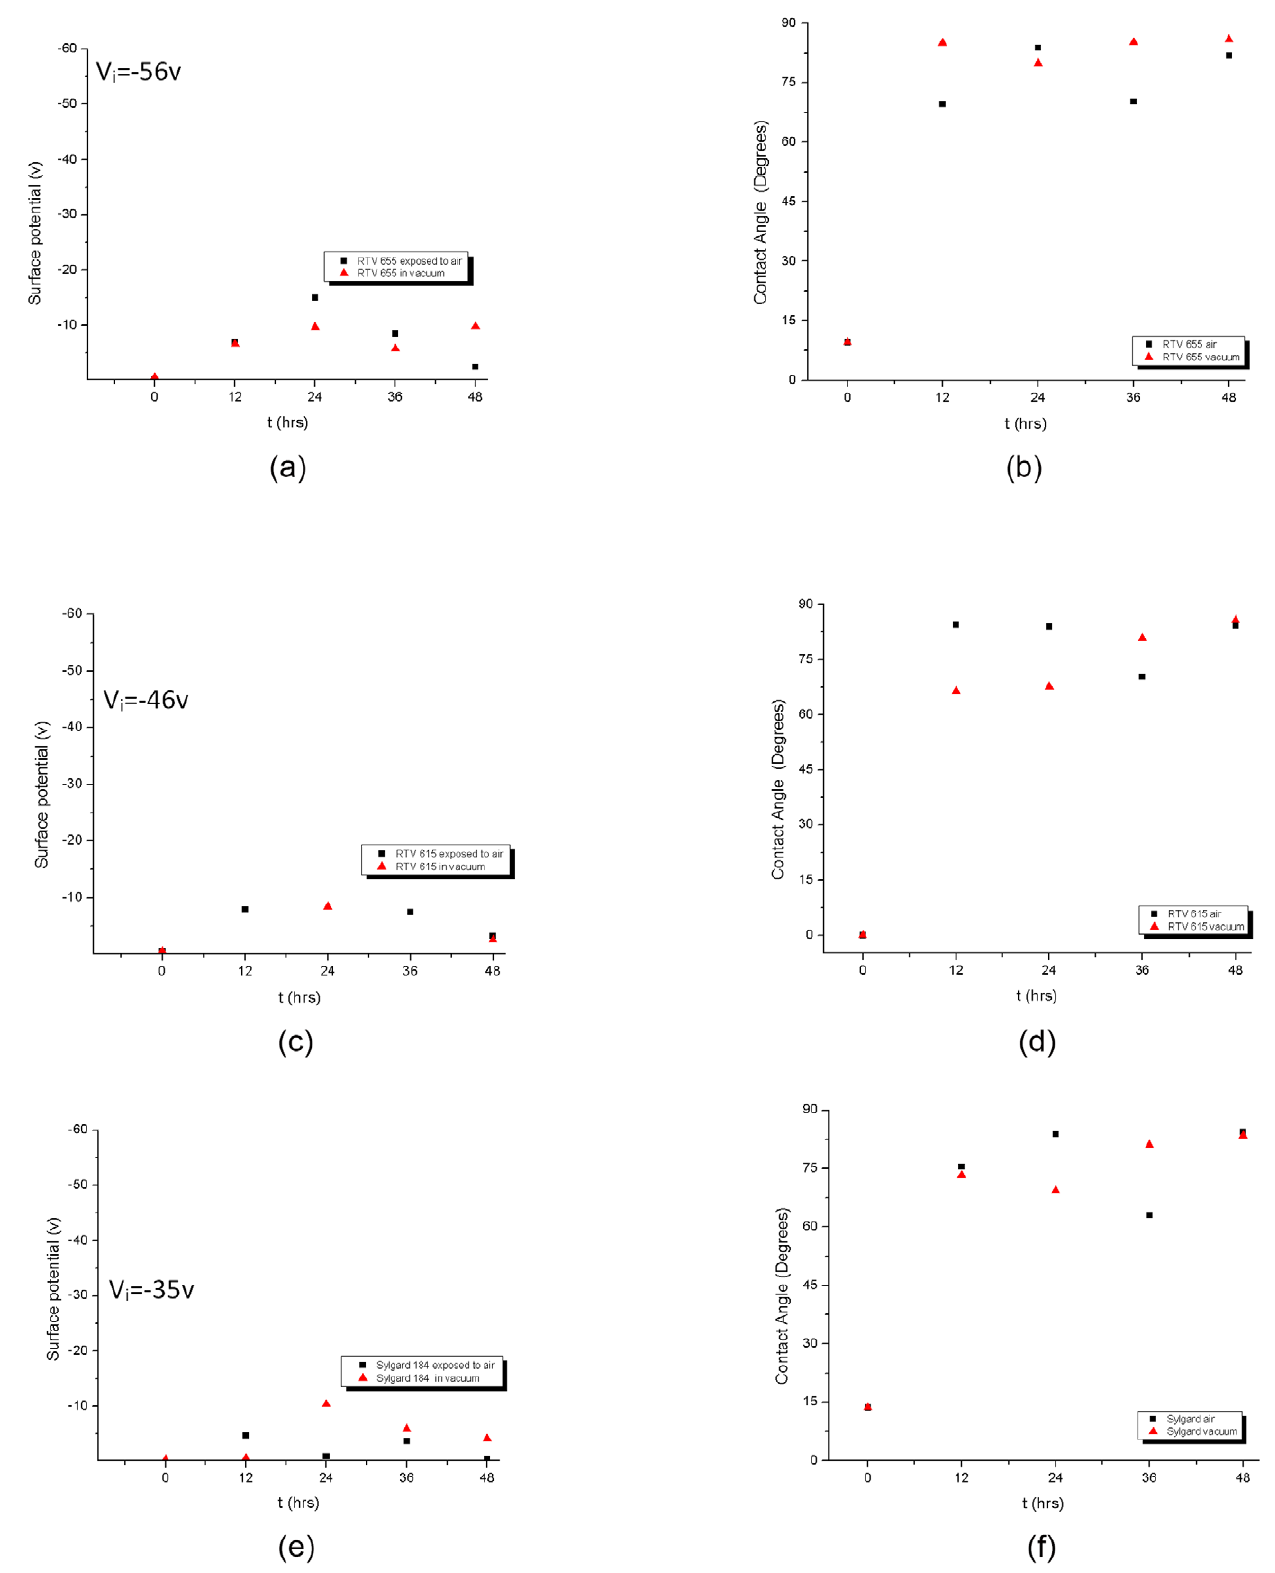
Figure 6. Post Ar plasma treatment recovery. Monitoring recovery of surface potential (a, c, e) and contact angle (b, d, f) after 60 sec Ar plasma treatment for RTV 655, RTV 615, and Sylgard 184. Recovery conditions under vacuum and at atmospheric pressure were also compared. The surface hydrophobicity of all three polymers recovered within the first twelve hours while the surface potential remained at values close to zero even 48 hrs after treatment. Recovery rate appears to be independent of the storage conditions of vacuum versus ambient.